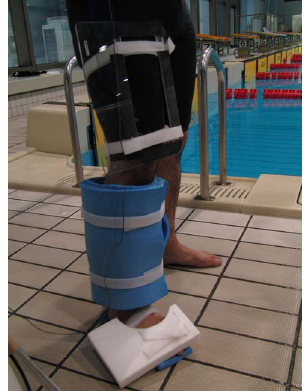
Fig. 11 Photograph of manufactured